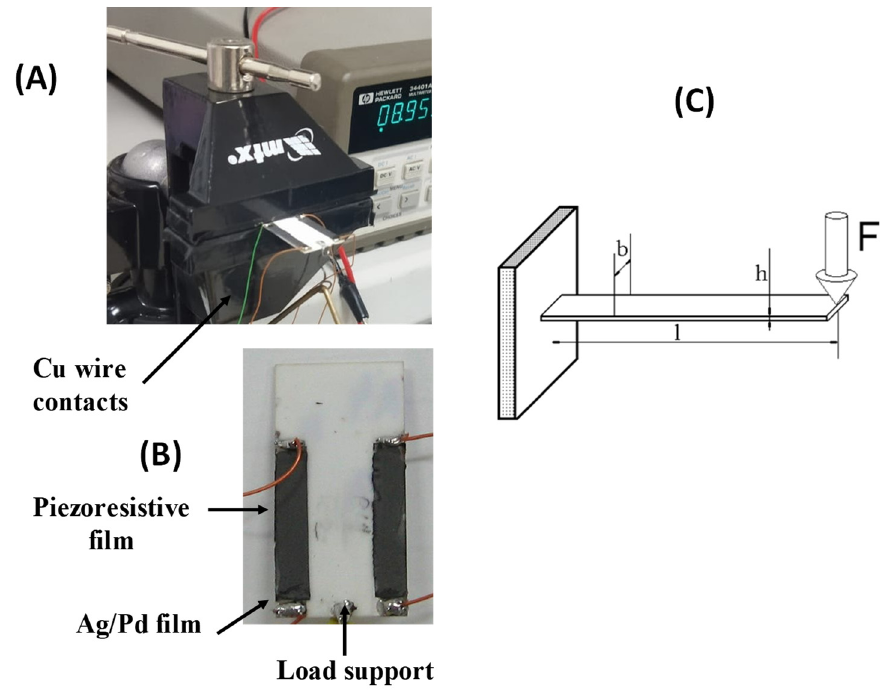
Figure 2. Experimental set up for measurements of electrical response under strain deformation: ( A ) Fixation of a sensor for strain tests, ( B ) Sensor view, ( C ) Schematic of the cantilever clamped beam geometry.